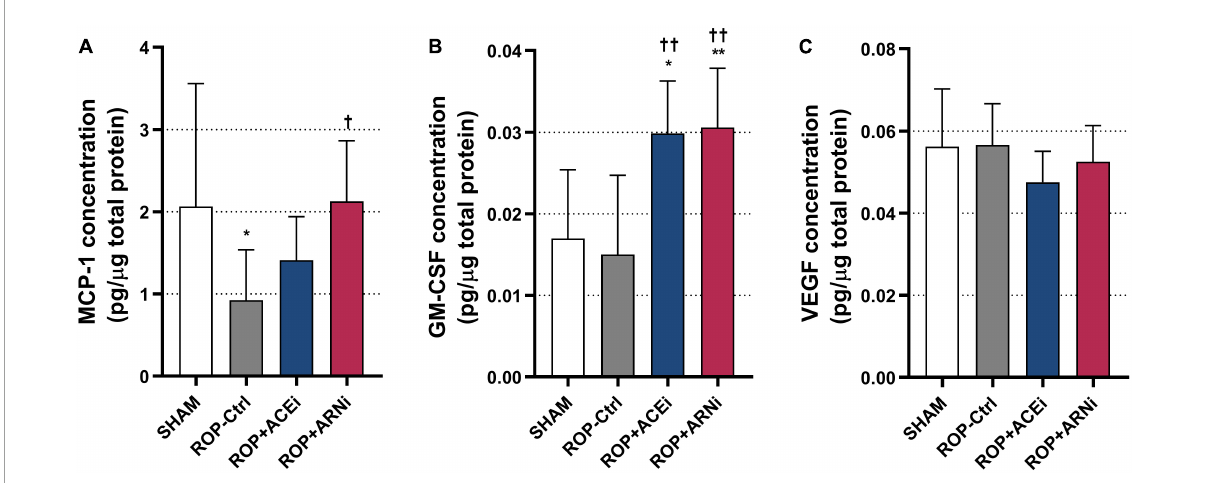
FIGURE5 Analysis of pro-arteriogenic cytokines. (A–C) Protein concentrations of pro-arteriogenic cytokines. * P ≤ 0.05, ** P ≤ 0.01, compared to SHAM. † P ≤ 0.05, †† P ≤ 0.01, compared to ROP-Ctrl.